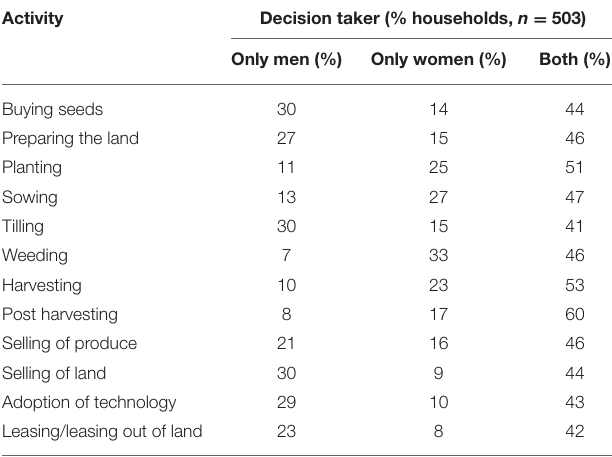
TABLE 2 | Gender disaggregated decision making in agricultural activities.